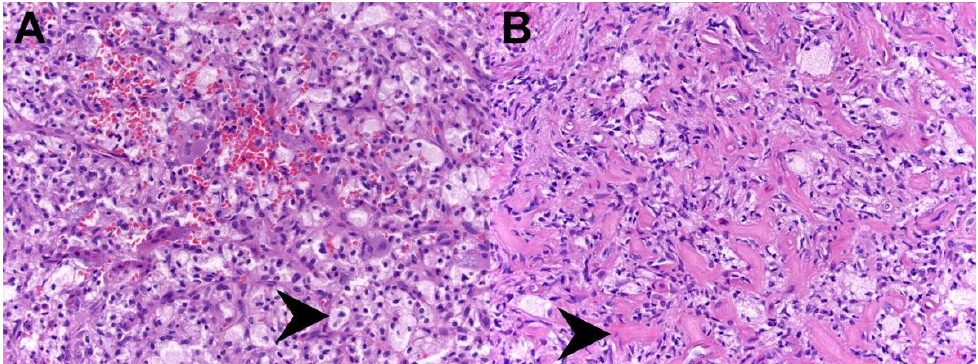
Figure 2. Histopathology. Hematoxylin and eosin (H&E) stained tissue from the initial biopsy which showed moderate prominence of histiocytic foam cells (black arrowhead), intermixed spindle cells, and scattered giant cells ( A ). H&E stained tissue following Denosumab therapy, showing disappearance of the giant cells, few foamy histiocytes, and predominance of short spindled cells in a collagenous stroma (black arrowhead) ( B ).